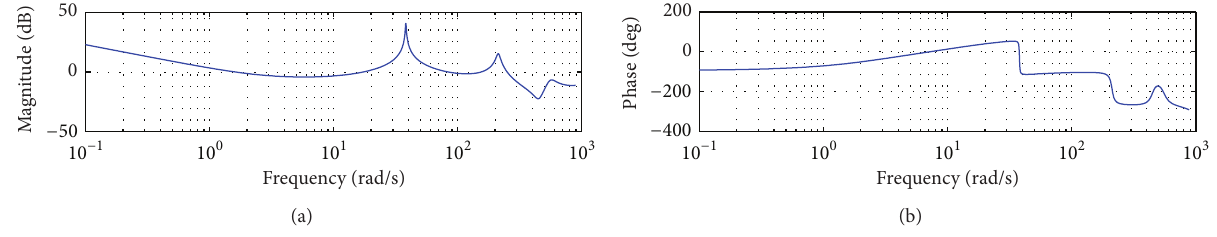
Figure 6: Bode characteristic of the open-loop transfer function based on the integer PID controller and the FE model: (a) magnitude, (b) phase.